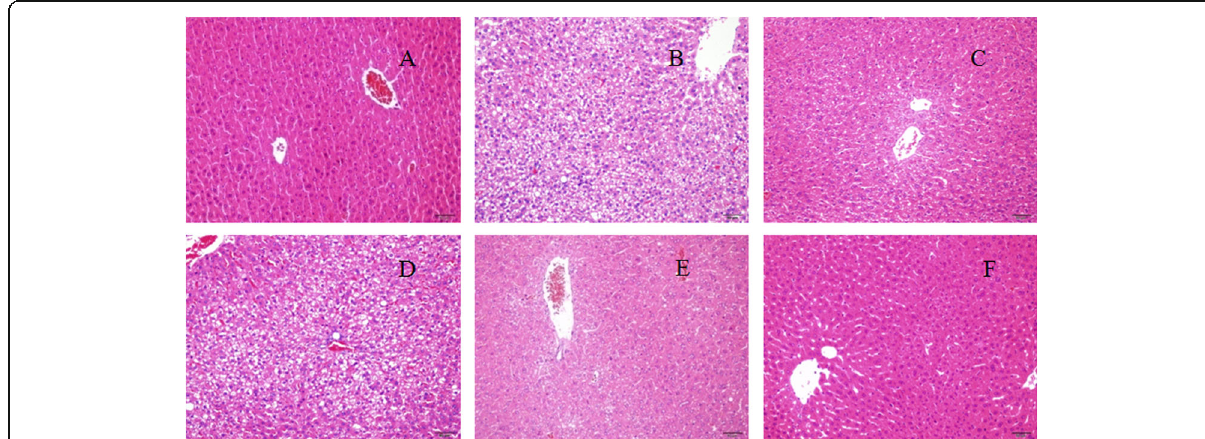
Fig. 2 Histopathological observation of liver in aging mice. Magnification, × 200: a normal control group; ( b ) model control group; ( c ) positive control group; ( d ) RIP of low dose group; ( e ) RIP of medium dose group; ( f ) RIP of high dose group